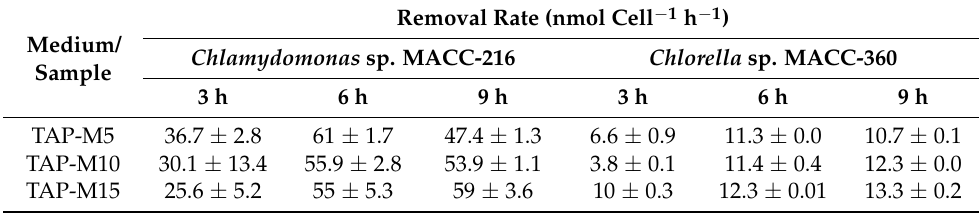
Table 3. Nitrate removal rate of Chlamydomonas sp. MACC-216 and Chlorella sp. MACC-360 at three different time points. Values are represented as mean ± standard deviation.